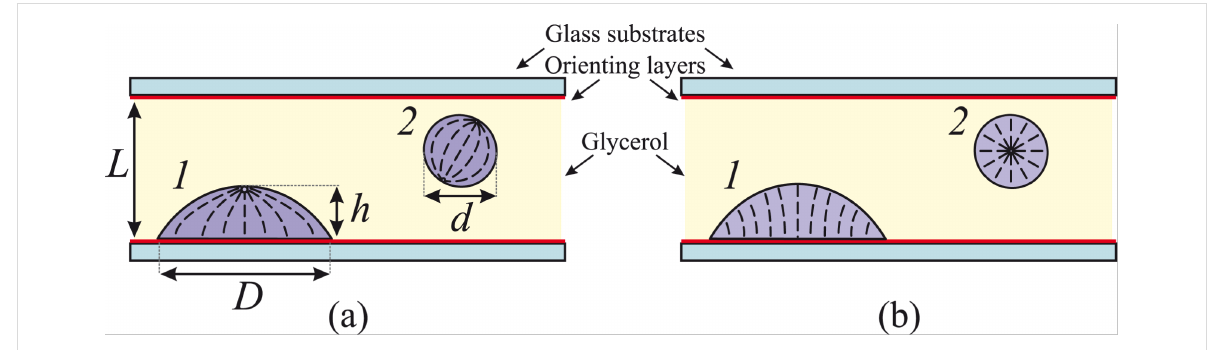
Figure 1: Sketch of a glass cell with NLC droplets embedded into glycerol with planar (a) and homeotropic (b) boundary conditions. The NLC director distribution in the droplet resting on the solid substrate ( 1 ) and in the spherical droplet in the bulk of glycerol ( 2 ) are shown by dashed lines. Adapted from [30], with the permission of AIP